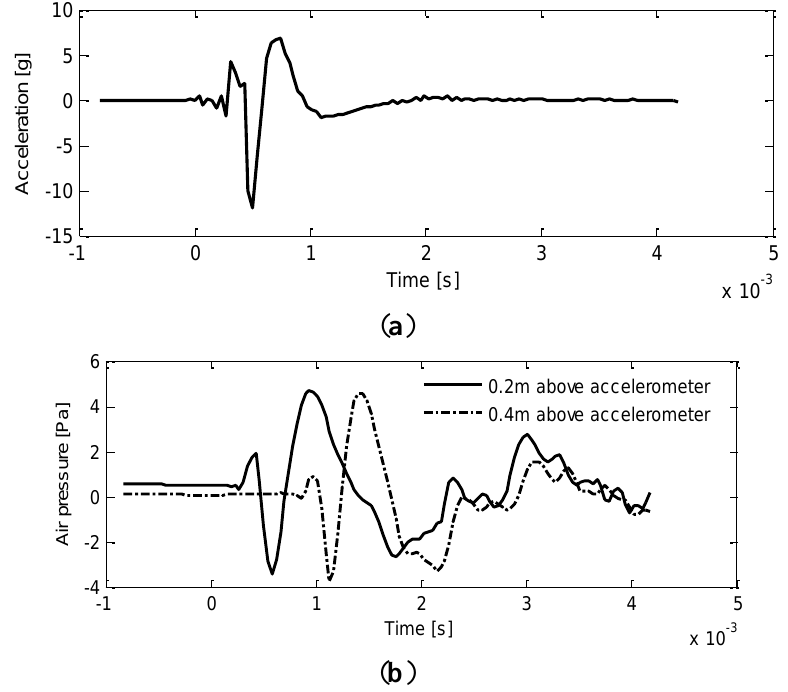
Figure 3. ( a ) Sample data collected by accelerometer data; and ( b ) Sample data collected by